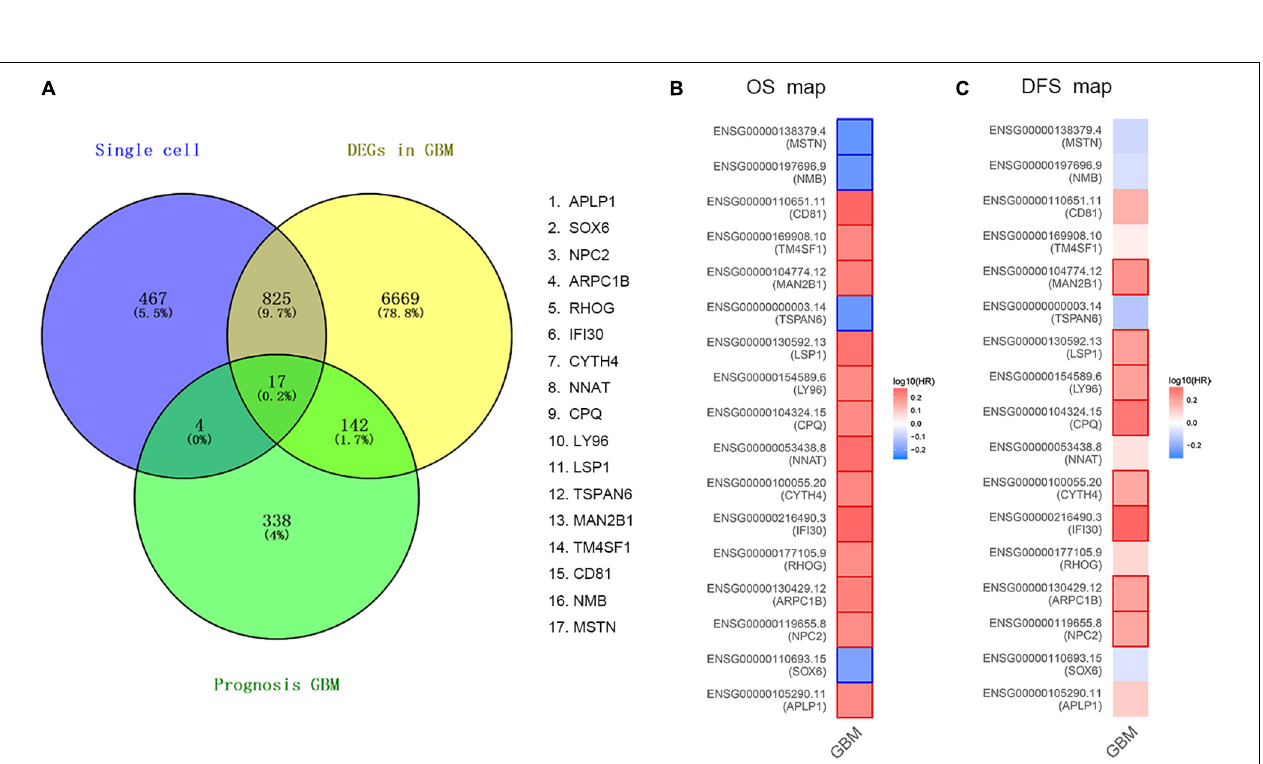
FIGURE 2 | Validation of common DEGs. (A) The common genes between our DEGs, TCGA cohort DEGs, and PRGs of GBM. Different color areas represent different datasets. The cross areas showed the commonly changed DEGs. DEGs were identified with classical t test; statistically significant DEGs were defined with P < 0.001 and | log2 fold change| > 1 as the cut-off criteria. (B) Overall Survival (OS) map of common DEGs. (C) Disease Free Survival (DFS) map of common